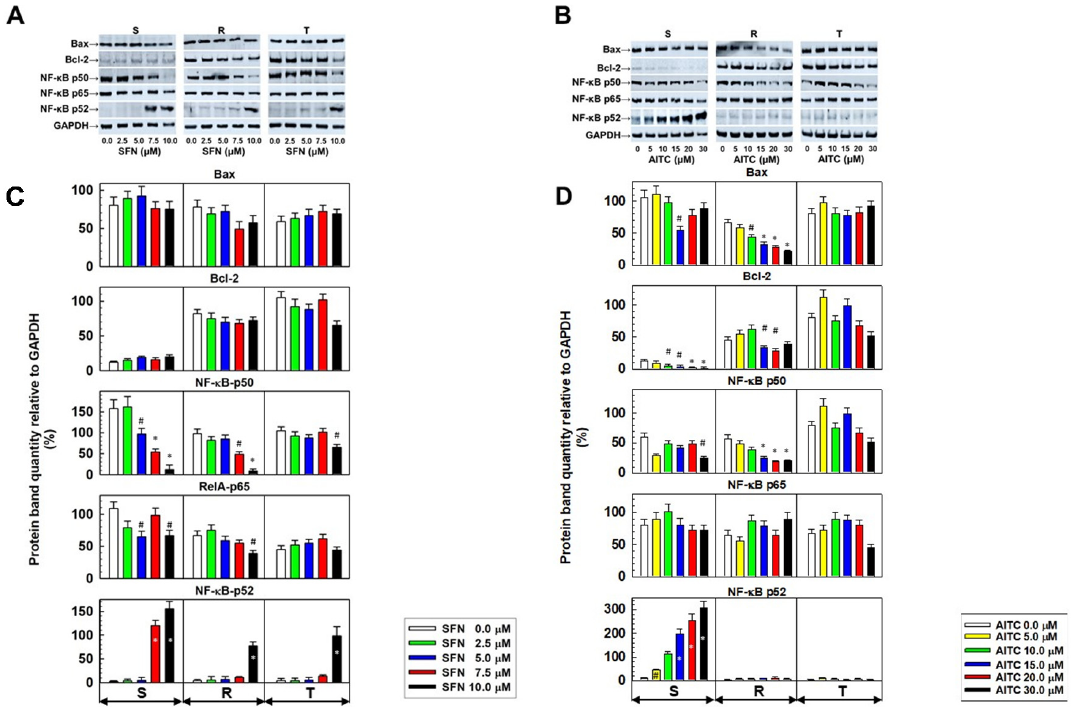
Figure 5. Expression of proteins that are active in apoptosis (Bcl–2, Bax, and the members of NF- κ B pathways: p50, P52 and p65) in S, R and T cells after 24 h of incubation in medium containing given concentrations of SFN or AITC. Panels A and B : Detection of proteins by Western blotting. GAPDH was used as an internal control. Data are representative of three independent measurements. Panels C and D : Densitometric quantification of protein bands from Western blots. Quantities are expressed as the mean ± S.E.M. of three independent measurements of data relative to the GAPDH signal. Data differ from values obtained in cells that were not incubated in the absence of either SFN or AITC at the levels: # – p < 0.05; * – p < 0.01.